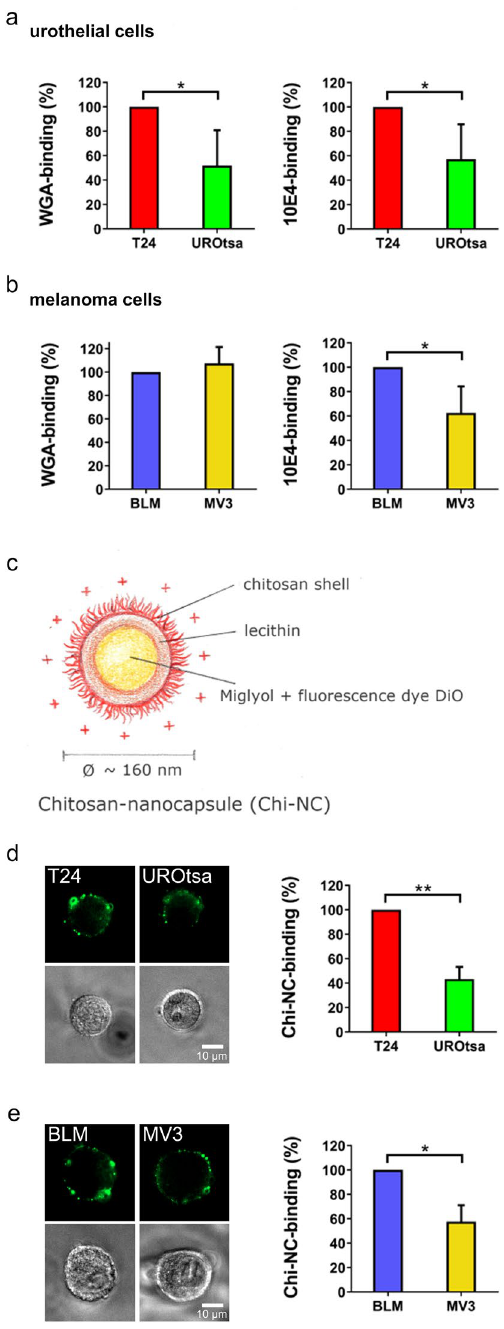
Figure 3. Expression of glycans and Chi-NC binding capacity of urothelial and melanoma cells. ( a , b ) Comparison of the WGA-binding ability and heparan sulphate expression (10E4-binding) of urothelial cells ( a ) and melanoma cells ( b ). ( c ) Schematic illustration of Chi-NCs. ( d , e ) Urothelial cells ( d ) and melanoma cells ( e ) were treated with Chi-NCs (1.78 × 10 12 particles mL −1 ). Prior to flow cytometry, binding of Chi-NCs (green) to the cellular surface was verified by fluorescence microscopy (upper panels). Presence of cells was proven by phase-contrast microscopy (lower panel). Scale bars = 10 µm. The bar diagram shows the quantitative evaluation of flow cytometric results. Data were normalised to the corresponding mean fluorescence of T24 or BLM cells. Data are presented as mean ± SD ( n = 3–4, * p < 0.05, ** p <